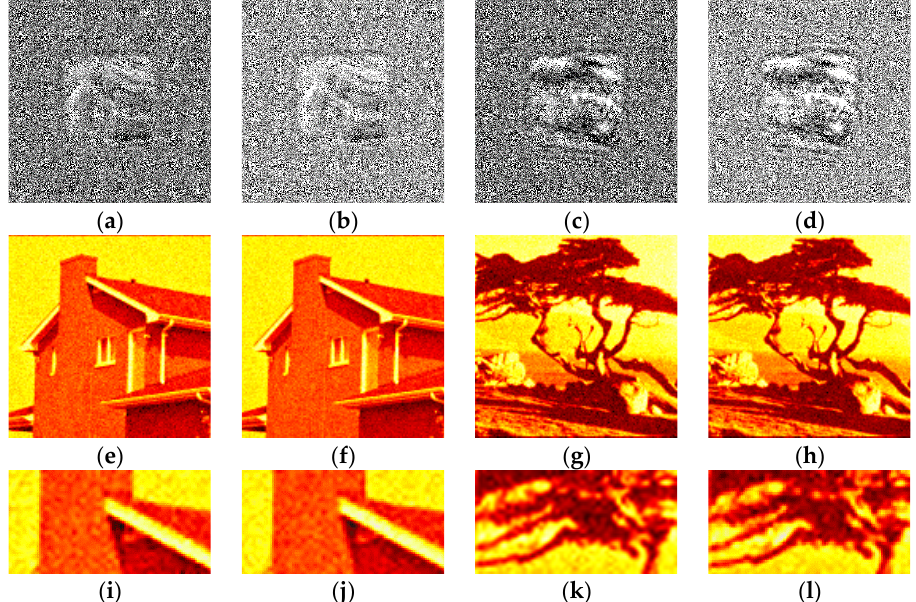
Figure 10. Examples of synthesized binary inline Fresnel holograms containing the “House” and the “Tree” images after application of DSRT technique, corresponding reconstructed images and their enlarged fragments. Holograms were binarized using the Otsu ( a , e , i and c , g , k ), and Sauvola ( b , f , j and d , h , l ) methods. Table 2. Quality and diffraction efficiency of the numerically reconstructed binary holograms.